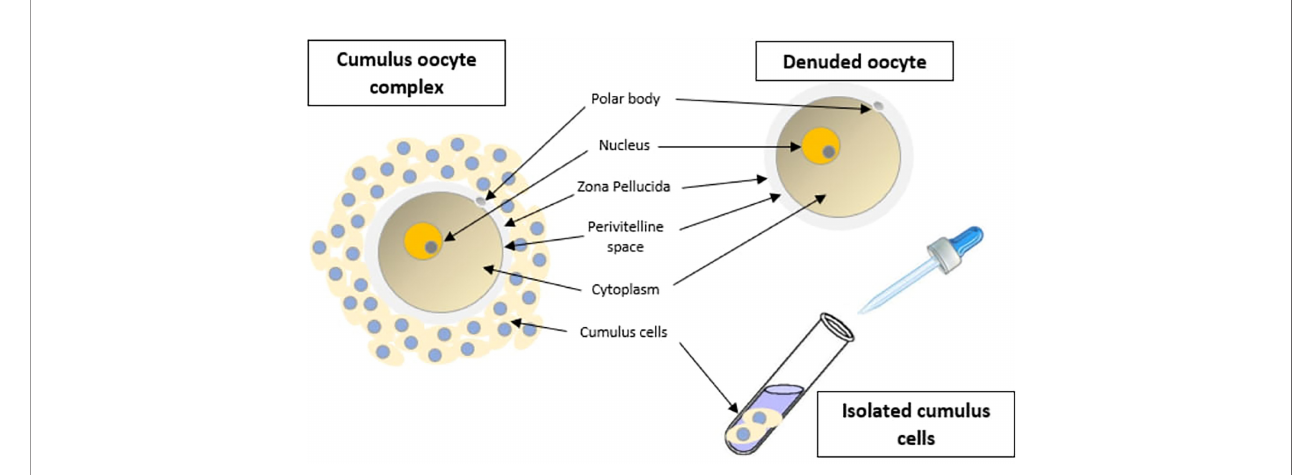
FIGURE 2 | Close-up diagram of the cumulus-oocyte